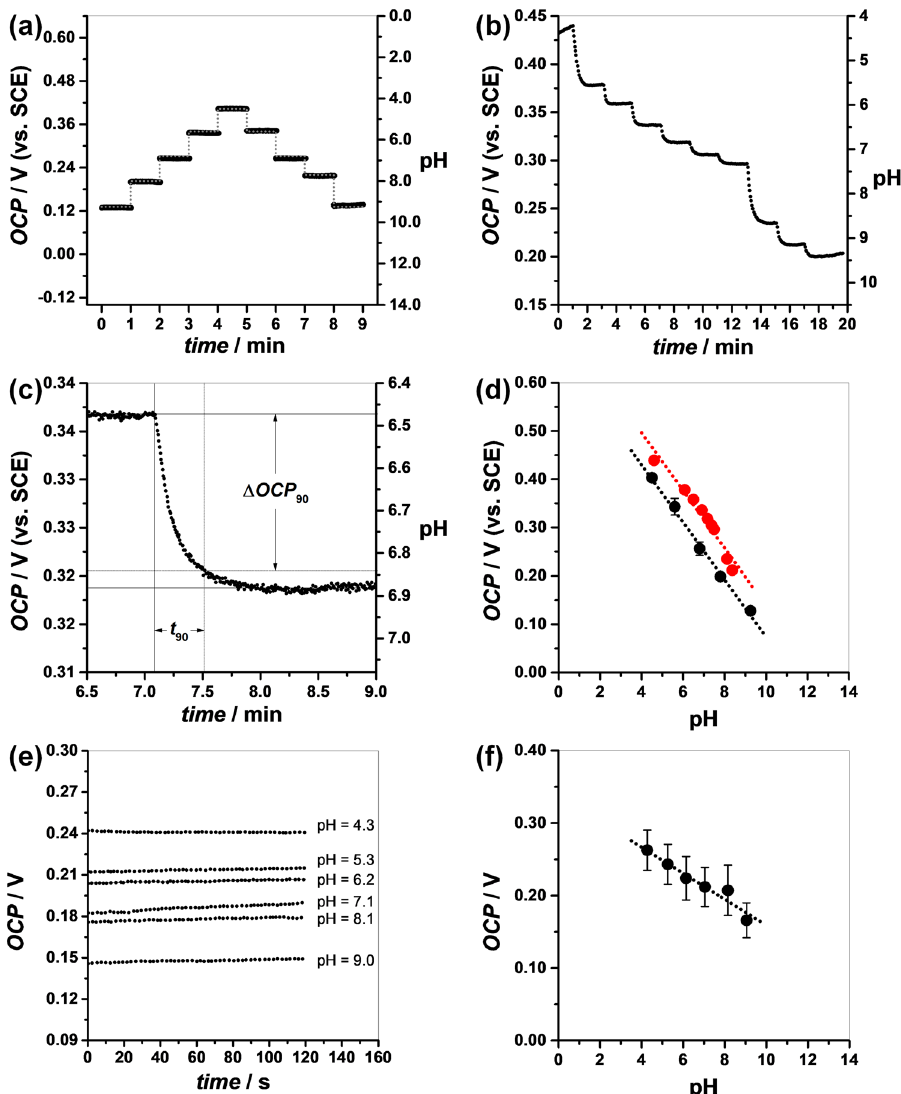
( b ) Same as ( a ) in artificial sweat. ( c ) Analysis of transition between pH 6.44 and 6.84 in artificial sweat. ( d ) Variation of OCP with the pH of the electrolyte ( ● ) or of artificial sweat ( ● ). ( e ) OCP of the hydrogel embedded pH sensor in artificial sweat with different pH values function of time. ( f ) Variation of OCP (n = 5) of the hydrogel embedded pH-sensor with the pH of the artificial